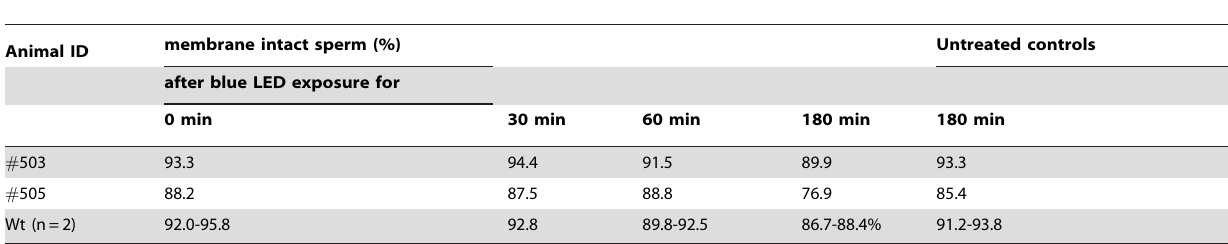
Table 3. Effects of Venus excitation on membrane integrity of spermatozoa.